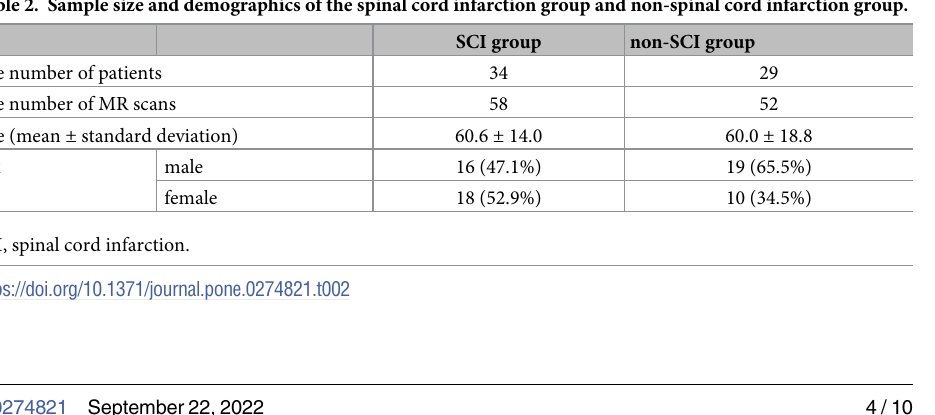
SCI group non-SCI group